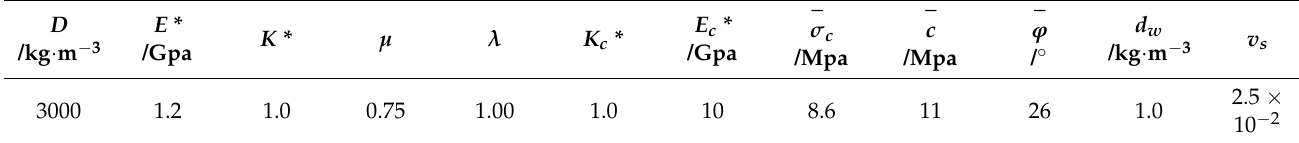
Table 3. Mesoscopic parameters of the PFC model of gangue.(D is particle density; E * is contact elastic modulus; K * is stiffness ratio; µ is friction coefficient; λ is parallel bonding radius product factor; K c * is parallel bonding stiffness ratio; E c * is elastic modulus of parallel bonding; σ c is parallel bonding tensile strength; c is parallel bonding force; ϕ is parallel bonding friction angle; d w is fluid density; v s is fluid viscosity